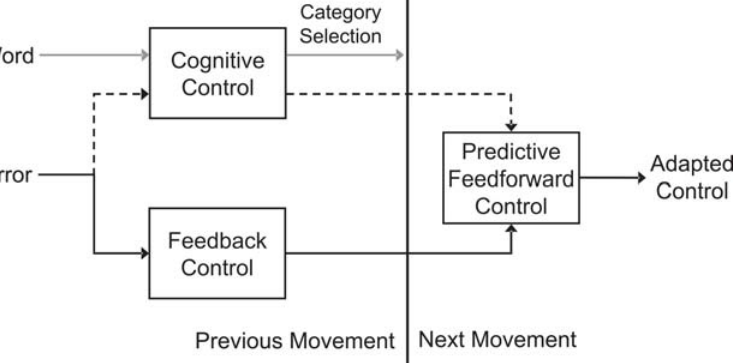
Figure 5. Possible model of systems involved in within-movement and across-movement motor control. During the pulsed movement, movement errors engage the feedback control system to correct the movement online (solid route) and the errors engage cognitive control systems (dashed route). The word categorization task also engages cognitive control differentially depending on the category ambiguity of the word (gray route). Feedback error learning systems update the predictive feedforward control on the next movement (solid route). Cognitive control also influences predictive control on the next movement (dashed route), but is degraded depending on the category ambiguity of the presented word.